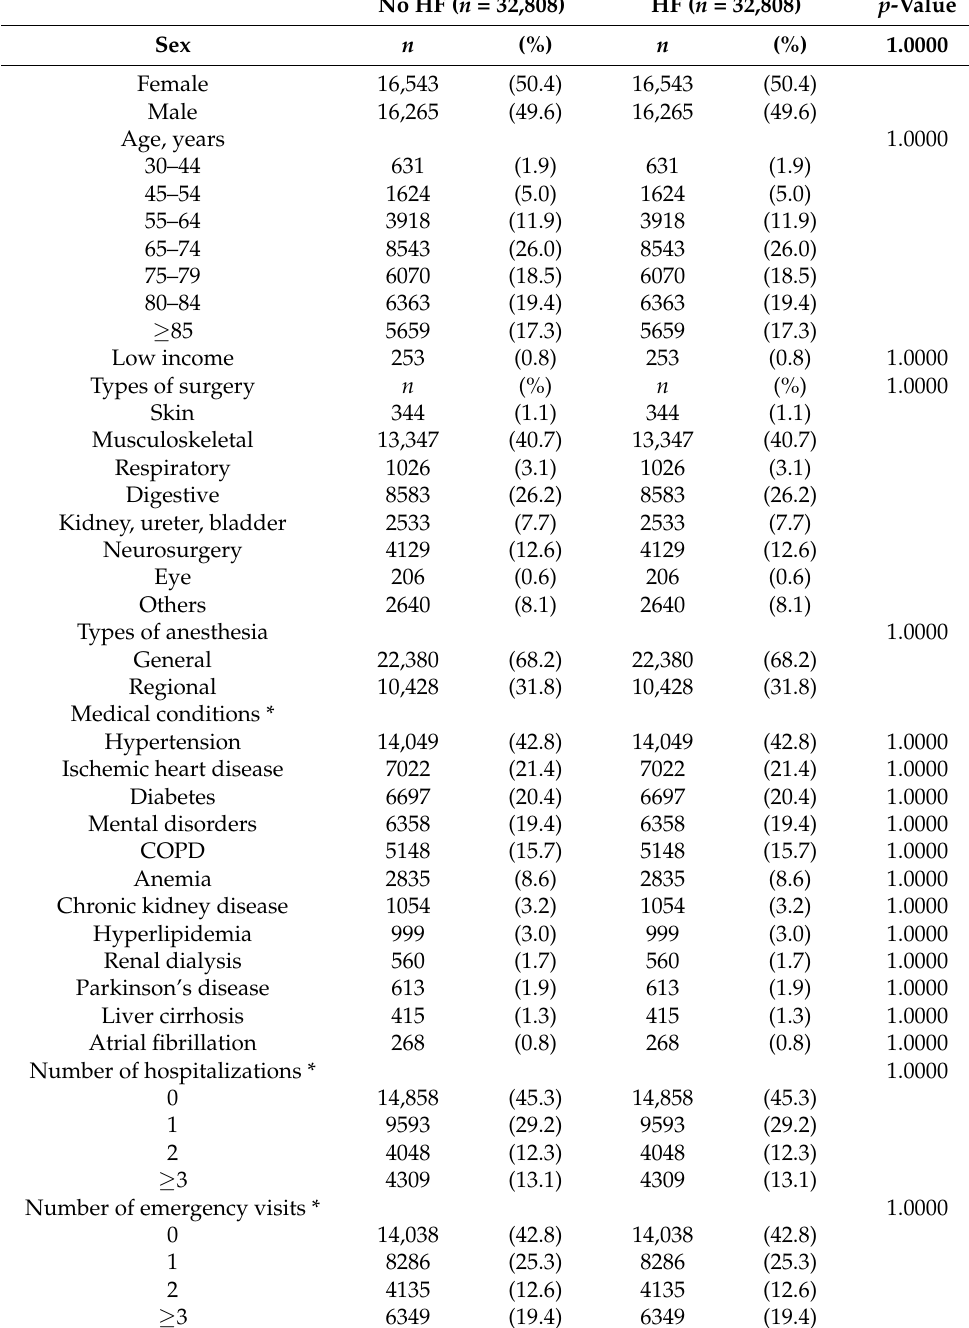
Table 1. Characteristics of surgical patients with and without heart